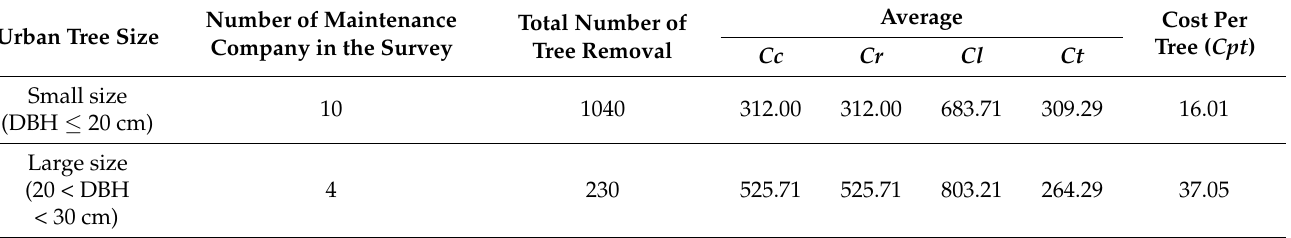
Table 3. Survey of tree removal at eastern China in 2018–2019, separated by tree DBH (currency unit: USD). Number of Urban Tree Size